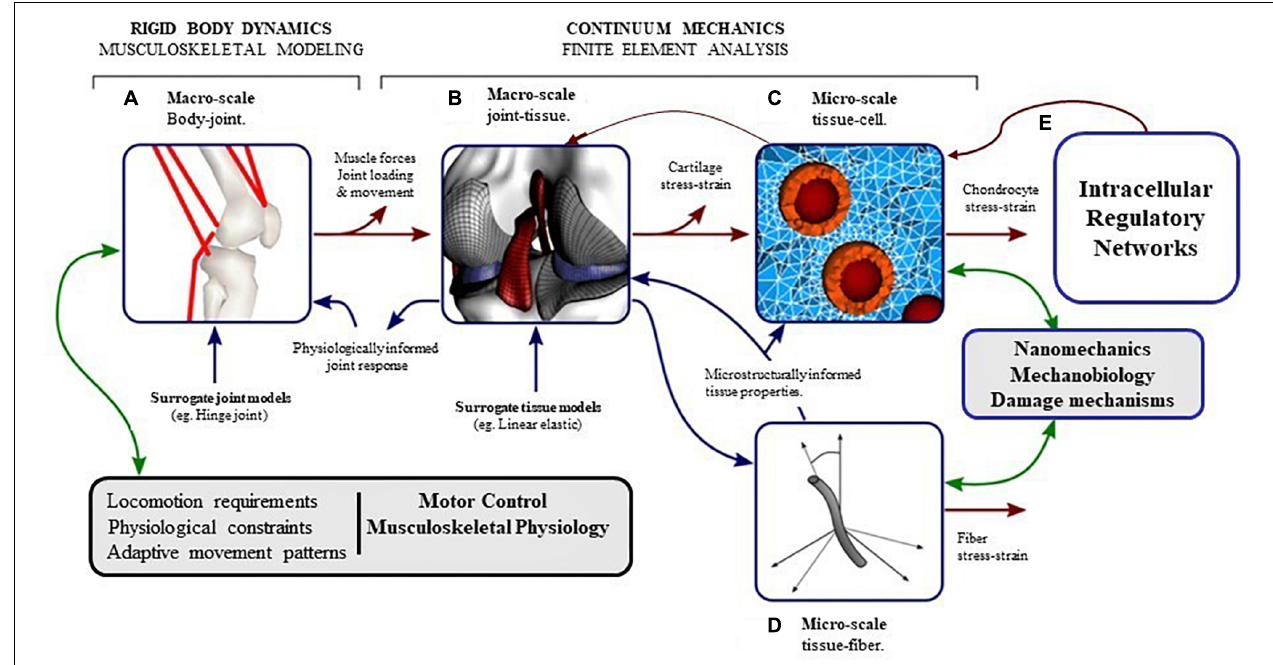
FIGURE 6 | The pathway of mechanical signal from joint level to cellular (intra-cellular) level can be understood by developing computational models at different length scales which interact with each other. (A) Musculoskeletal (MSK) modeling approaches coupled with gait analysis can calculate the kinematics and the forces in the joint during locomotion. (B) Finite element analysis of the whole joint with inputs from MSK models can provide contact pressures and forces, and the macroscopic stresses and strains in the tissues. (C) Micro-scale finite element analysis of chondrocytes in the extracellular environment, with inputs from macroscopic finite element analysis of the tissue can produce deformations and stresses in the chondrocytes in their native environment. (D) Micro-scale fiber architecture and multiphase modeling can make the cellular-level models event more integrated. (E) The intracellular processes triggered by mechanical signals acting on the cell can be modeled by (Gene) Regulatory networks (modified from Halloran et al.,